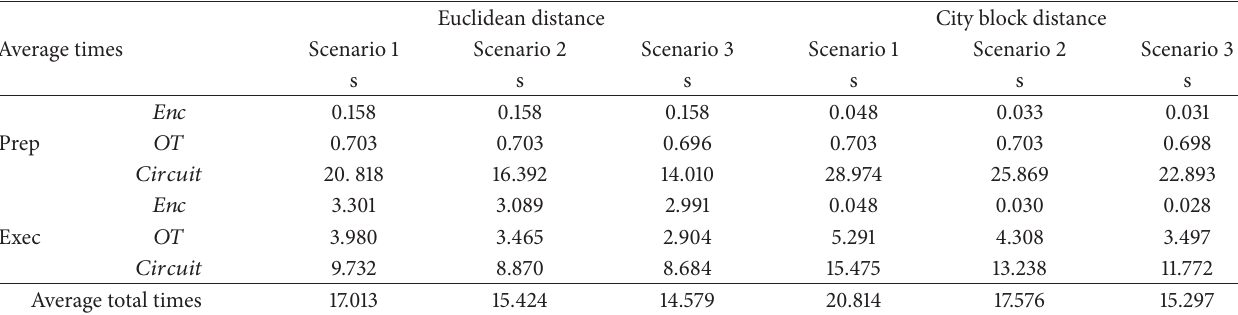
Table 6: Running time of the proposed methods.